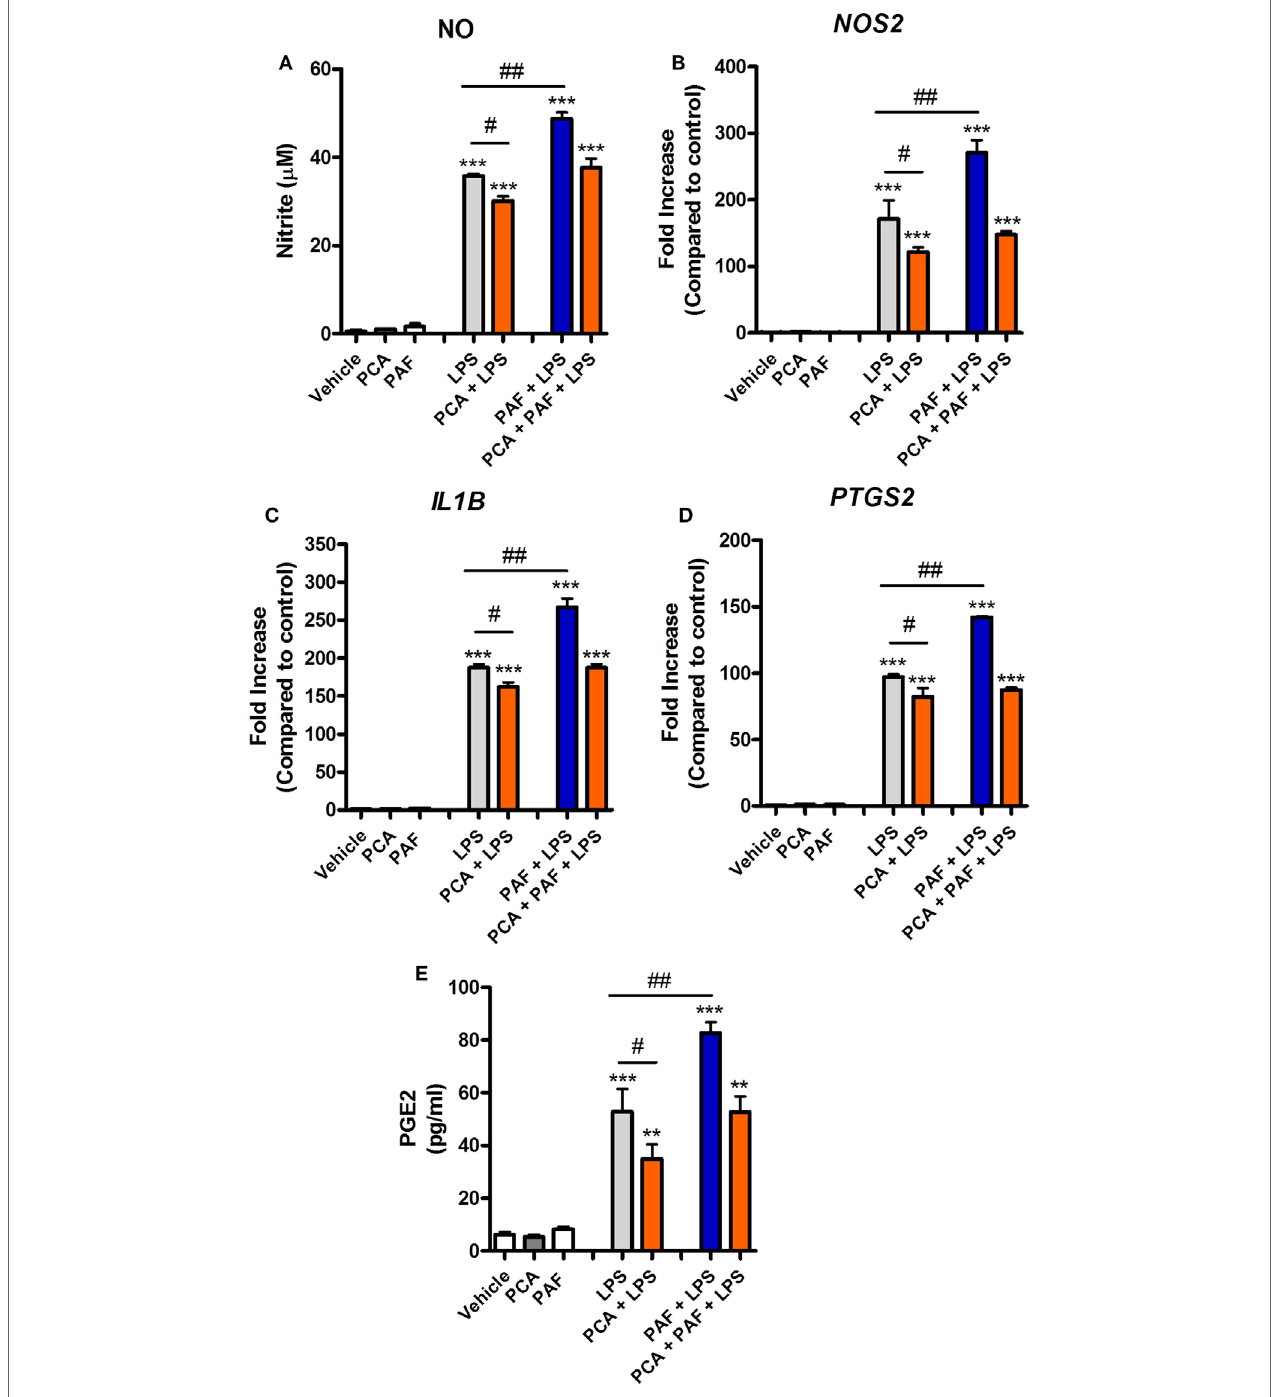
FigUre 5 | Exogenous platelet-activating factor (PAF) potentiates the pro-inflammatory response elicited by lipopolysaccharide (LPS) in chicken primary macrophages in a PAF receptor (PAFR)-dependent manner. After 6 h stimulation with PAF (10 µM) and/or E. coli LPS (10 ng/ml) in the presence or absence of PAFR antagonist PCA 4248 (10 µM), B13/B13 histocompatible chicken-derived bone marrow-derived macrophage (BMDM) supernatants were assessed for the presence of (a) nitric oxide, and cell lysates were used to analyze gene expression of (b) iNOS/ NOS2 , (c) IL-1 β / IL1B , and (D) COX-2/ PTGS2 by quantitative real-time PCR. Data are expressed as relative normalized expression (as compared to vehicle control group). (e) Prostaglandin E2 dosage by mass spectrometry in BMDM supernatants following the same aforementioned stimuli for 6 h. Values are mean ± SEM. ** P < 0.01 and *** P < 0.001 when compared to negative (vehicle) control groups. # P < 0.05 and ## P < 0.01 when compared to positive control